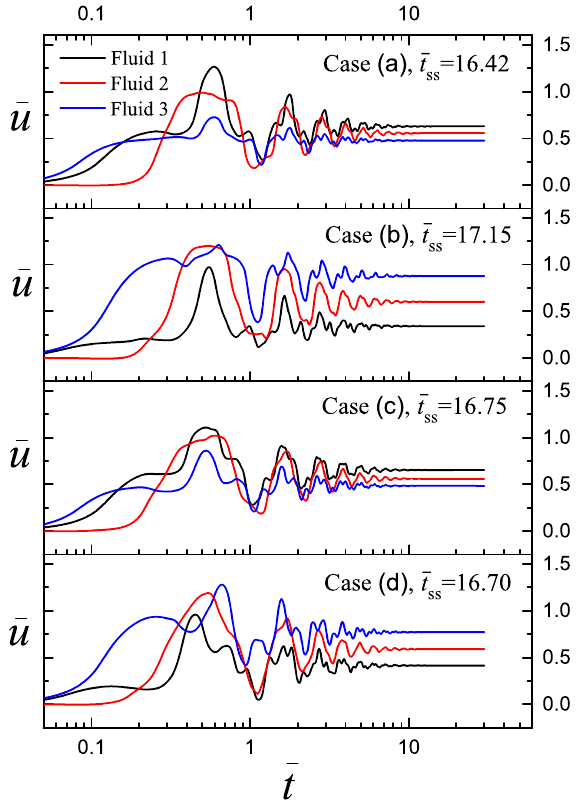
Figure 9. Velocity tracking of an electro-osmotic flow for Case ( a ) ¯ η 1,2,3 = ( 1.0,1.5,2.1 ) , Case ( b ) ¯ η 1,2,3 = ( 3.5,1.9,0.9 ) , Case ( c ) ¯ η 1,2,3 = ( 0.9,4.0,2.1 ) , and Case ( d ) ¯ η 1,2,3 = ( 3.0,9.0,1.0 )